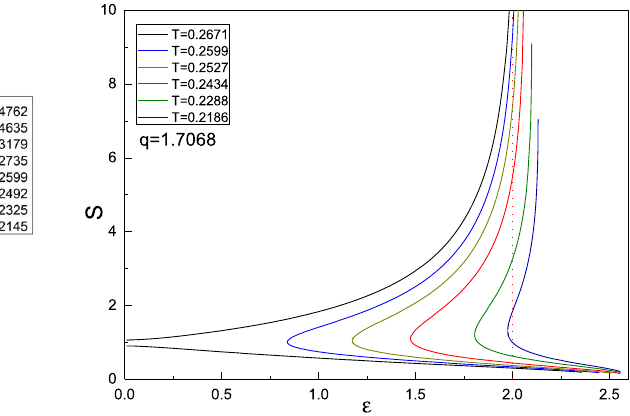
extremums divide the phase diagram of entropy into three regions. Right: for q = 1 . 7068, there is always one solution without extremum of temperature T . The vertical red dot lines represent ε =